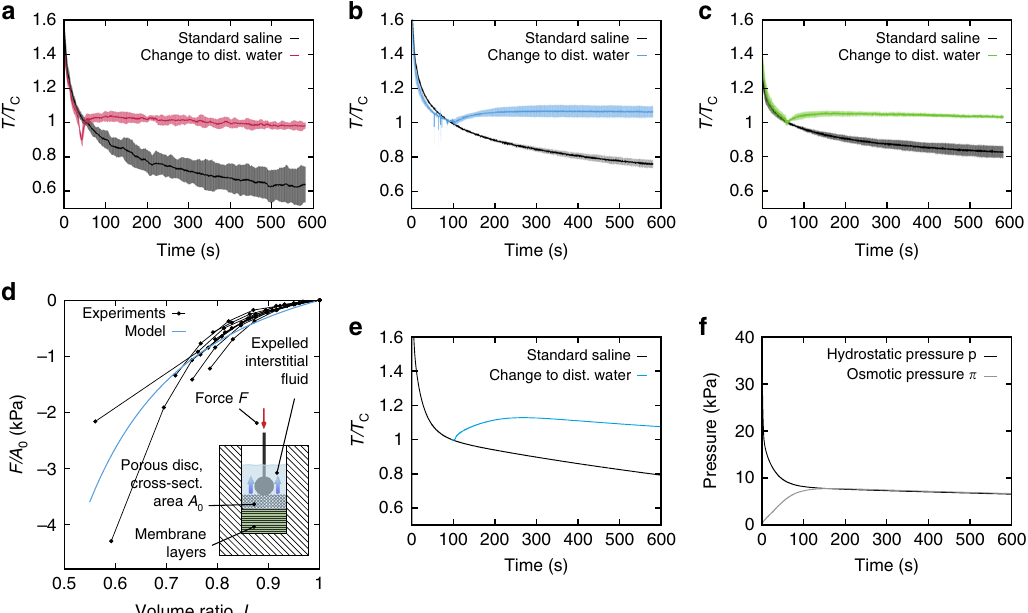
Fig. 2 Chemo-mechanically coupled tissue response. a – c Uniaxial (UA) tension relaxation experiments on ( a ) human amnion (hAM, n = 3, peak force 0.2 N), ( b ) bovine Glisson ’ s capsule (bGC, n = 3, peak force 0.8 N) and ( c ) porcine pericardium (pPC, n = 3, peak force 0.8 N) performed in 0.9% NaCl solution without ( black ) and with bath change to distilled water ( color ). The data are presented as mean ( solid curve ) and standard deviation ( shaded area ) and normalized by the corresponding tension value ( T C ) at the time point of change of bath. d Experimentally determined relaxed pressure (force per area) vs. volume ratio J curves for bGC sample ( n = 9 stacks, black ) together with the response of the biphasic model ( blue ). Inset : schematic illustration of the con fi ned compression set-up. e Temporal evolution of tension in simulated UA relaxation experiment for bGC without ( black ) and with ( blue ) bath change to distilled water. f Evolution of hydrostatic ( black ) and osmotic ( gray ) pressures in the center of the specimen, corresponding to e without change of